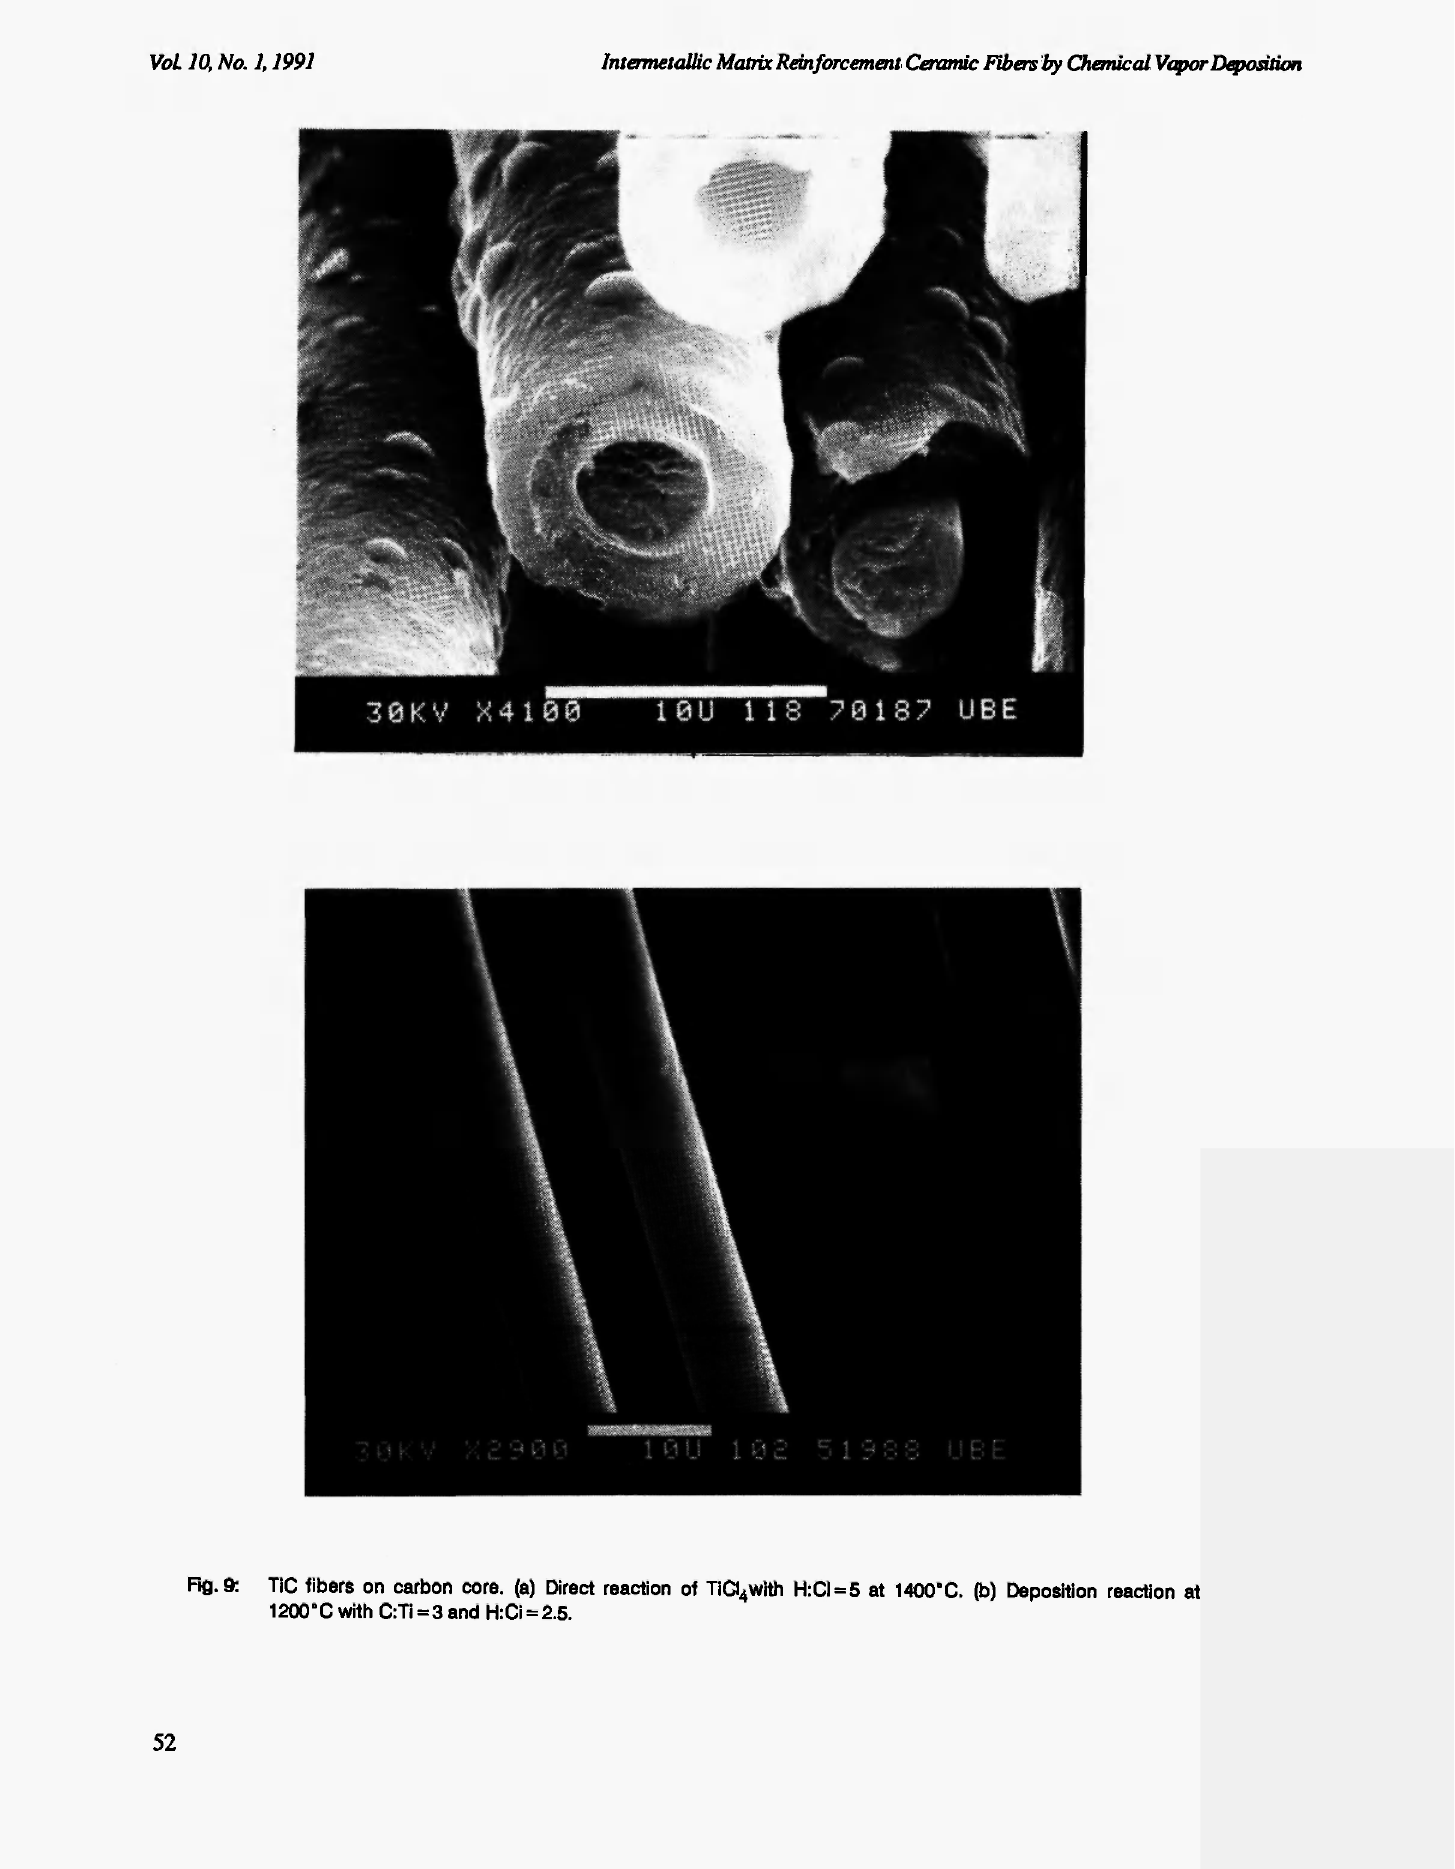
Fig. 9: TiC fibers on carbon core, (a) Direct reaction of Tia 4 with H:CI=5 at 1400°C. (b) Deposition reaction at 1200° C with C:Ti = 3 and H:Ci =